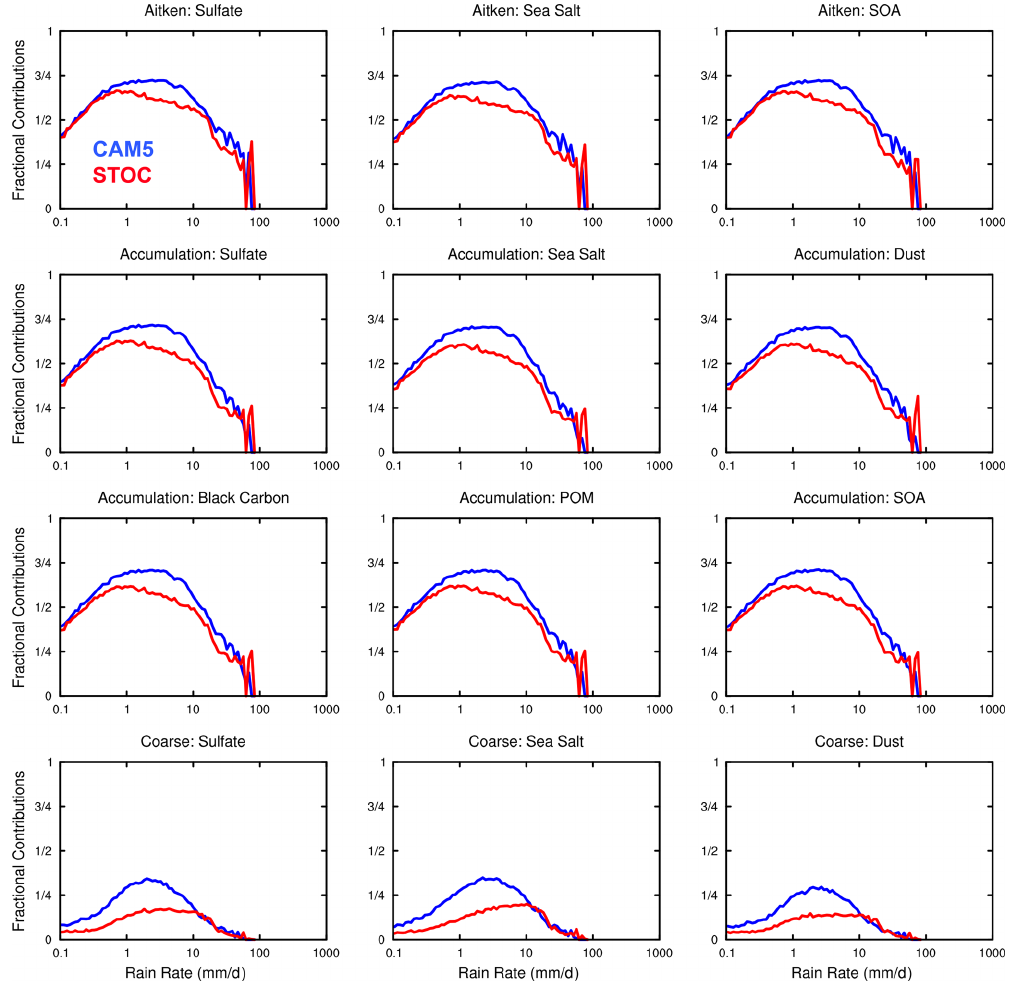
Figure 10. Same as Fig. 8, but over 50, 90 ◦